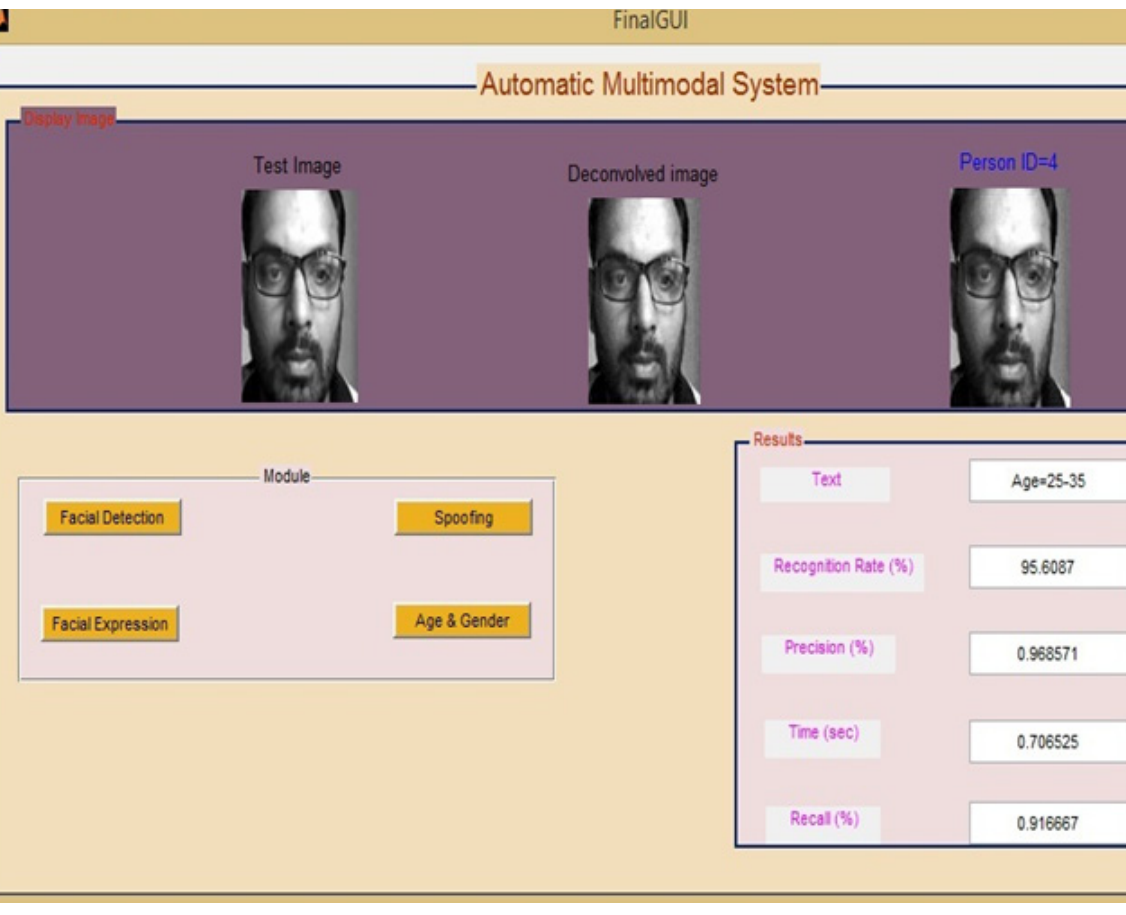
Figure 10. Overall GUI of Proposed Work.